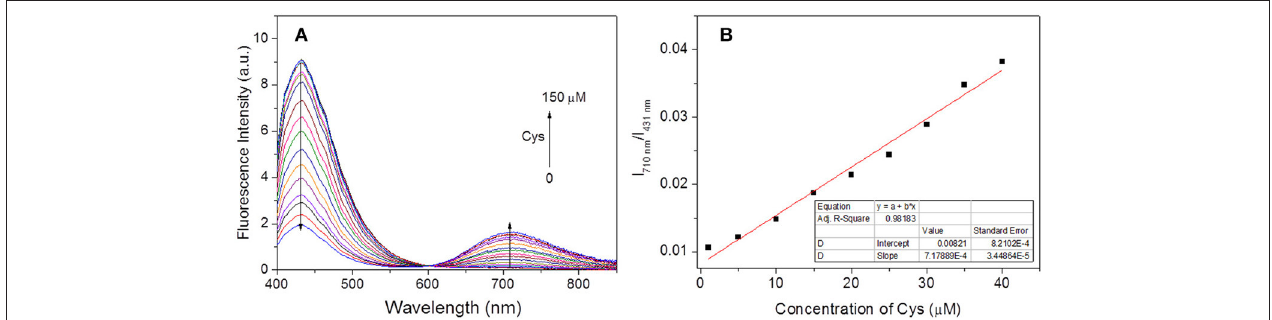
FIGURE 4 | Evolution of fluorescence spectra of HBT-Cys (10 µ M) with addition of various amount of Cys (0–150 µ M) (A) and the corresponding linear relationship of fluorescence intensity ratio (I